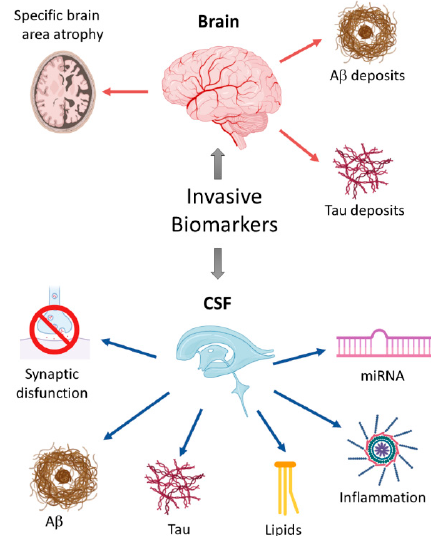
Figure 1. Schematic overview of invasive biomarkers. Different biomarkers have been used to detect early anatomical changes in the brains of people with mild cognitive impairment, including the atrophy of specific brain areas like the locus coeruleus or the hippocampus, and the presence of typical protein aggregates such as extracellular amyloid plaques or intracellular Tau-containing neurofibrillary tangles (upper panel). Additionally, biomarkers of Alzheimer’s disease (AD)-related degenerative processes like synaptic dysfunction, neuroinflammation, oxidative stress, or neuronal loss can be measured in the cerebrospinal fluid of AD patients. The detection of miRNAs represents a novel and promising tool for the early AD diagnosis (lower